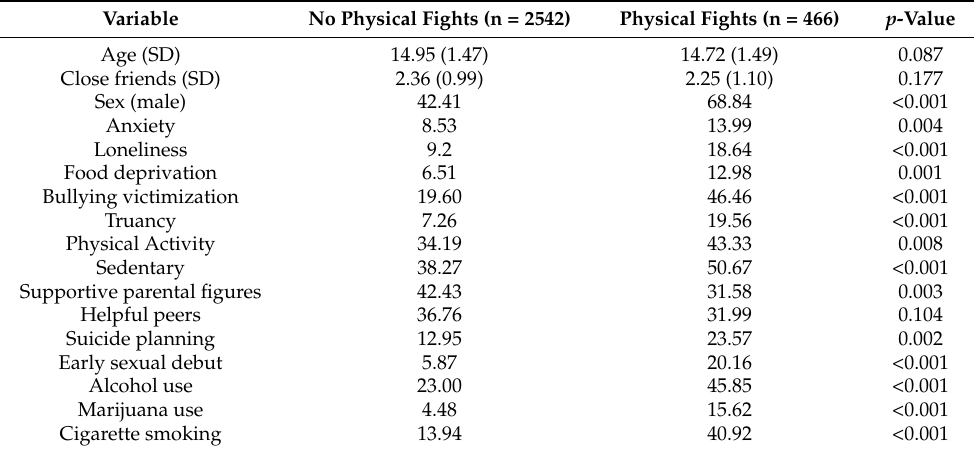
Table 2. The distribution of selected factors according to categories of physical fighting among school-attending adolescents in Mauritius, GSHS